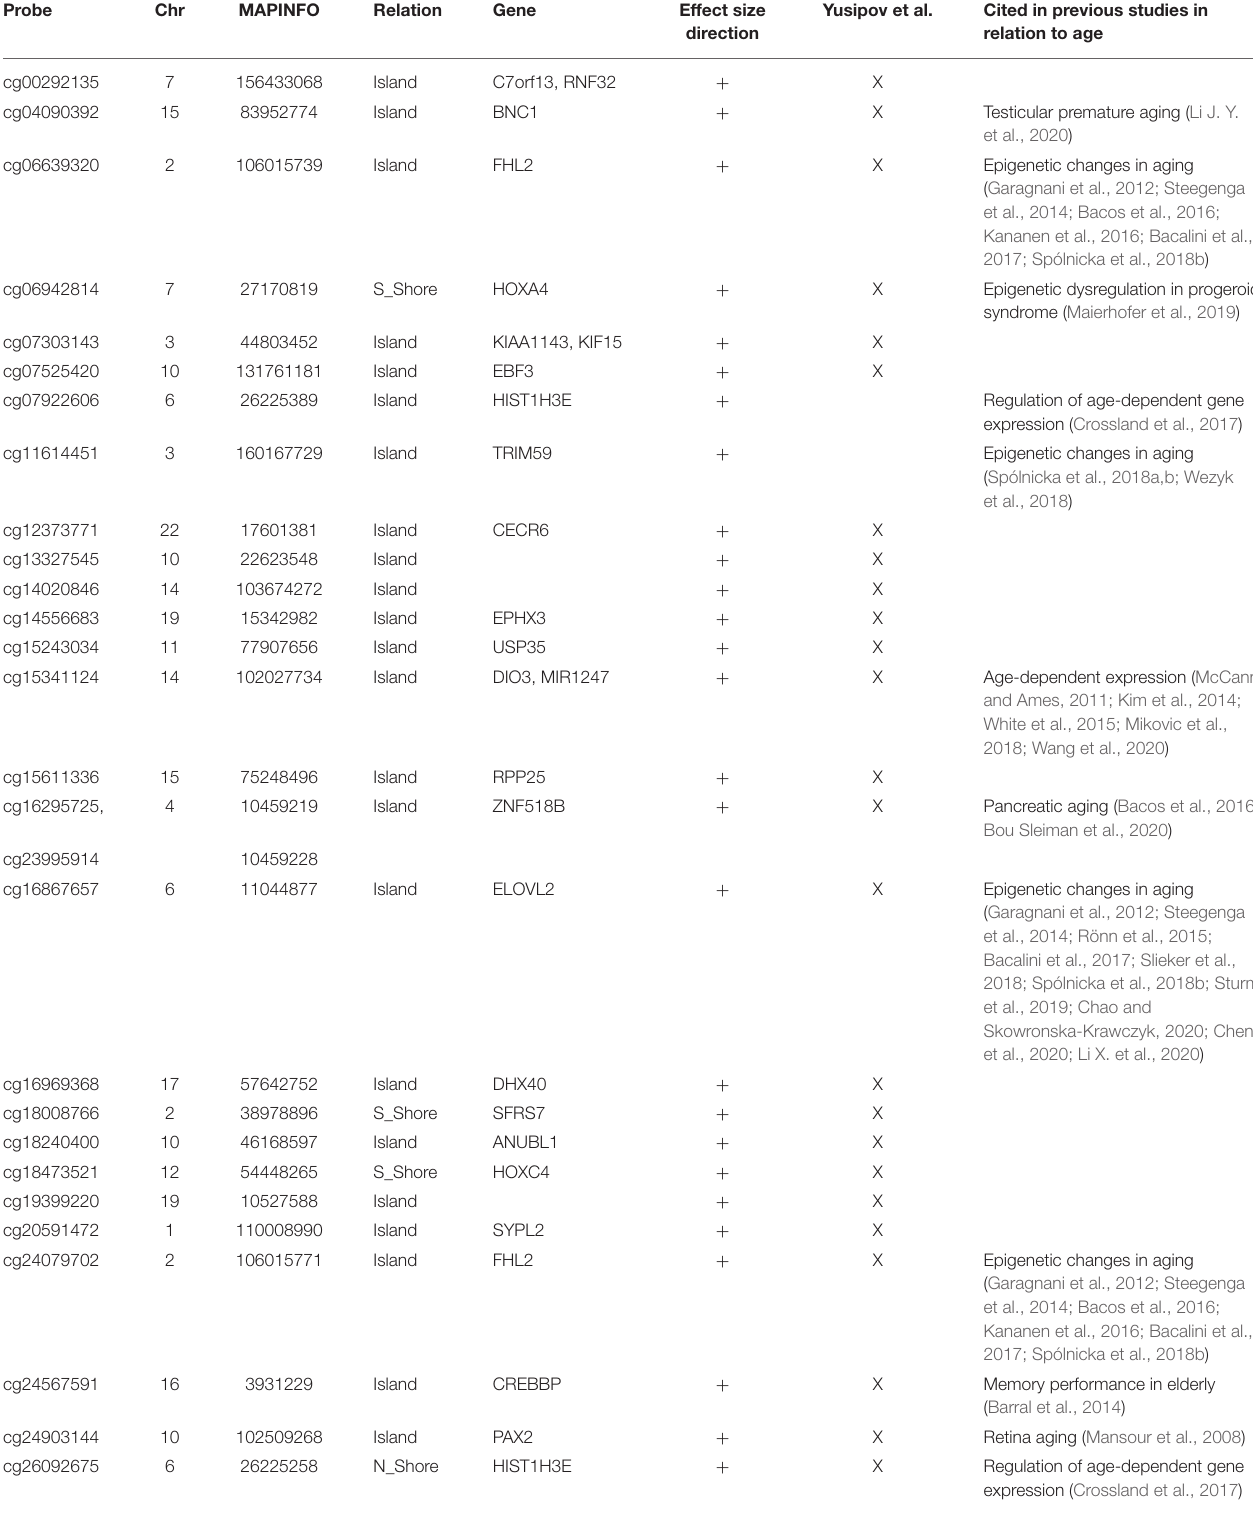
TABLE 4 | aDMPs resulting from cross-region analysis.